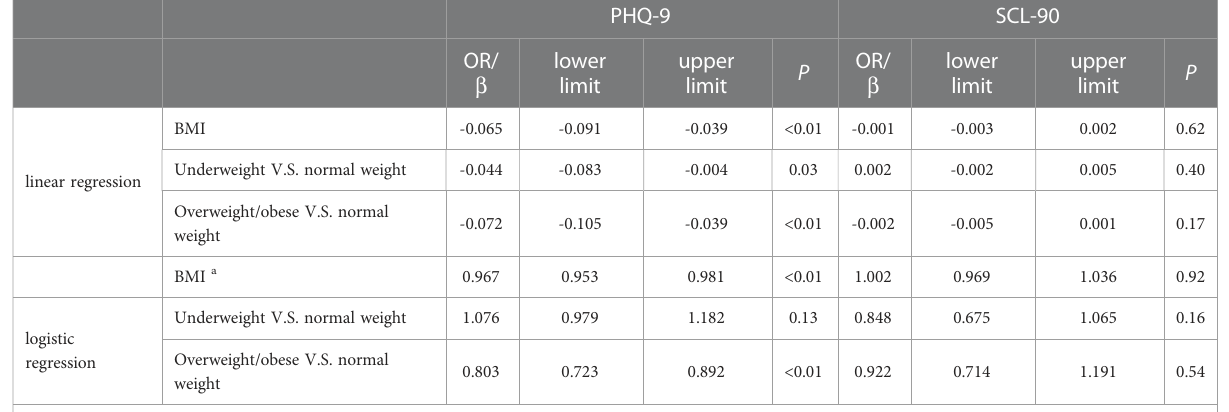
TABLE 3 The association between pre-pregnancy BMI and depressive phenotypes: Multivariable analysis.